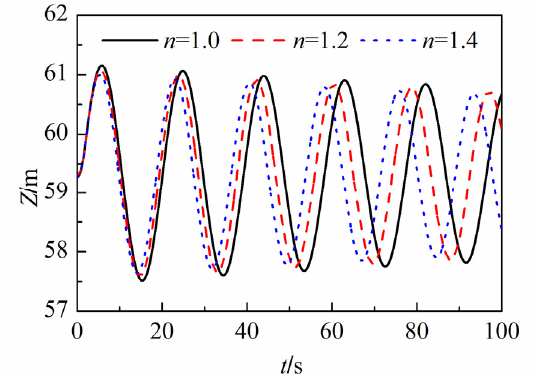
Figure 20. Oscillation of water